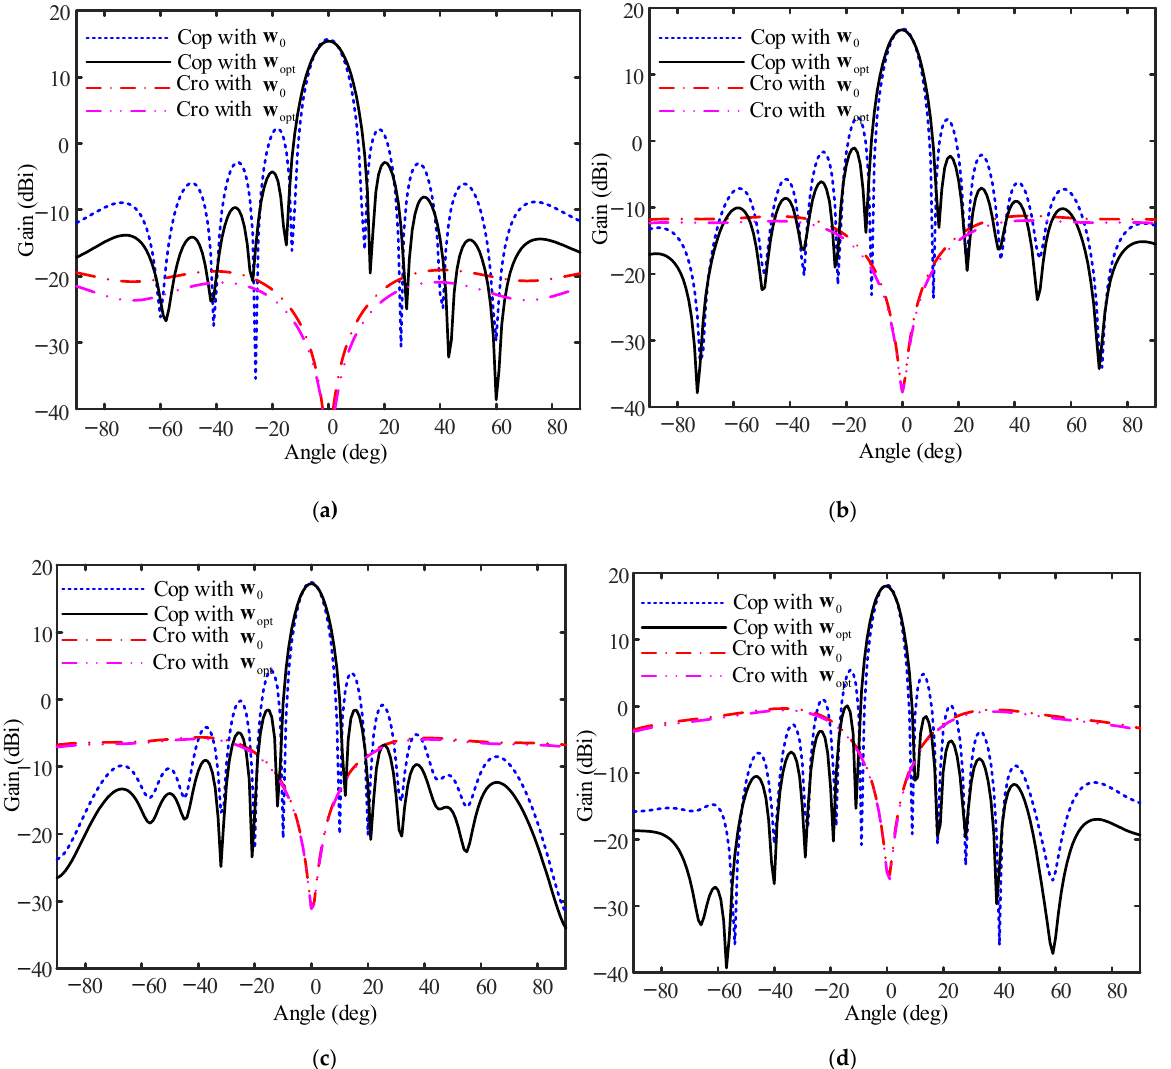
Figure 11. Co-polarization and cross-polarization patterns of the 8-element linear array at different frequencies before and after applying the optimal weight vectors in Table 5. ( a ) 7 GHz, ( b ) 8 GHz, ( c ) 9 GHz and ( d ) 10 GHz. Table 7. The PSLLs and PCPLs of the 8-element linear array before and after applying the proposed low PSLL beampattern synthesis approach at 7 GHz, 8 GHz, 9 GHz and 10 GHz.